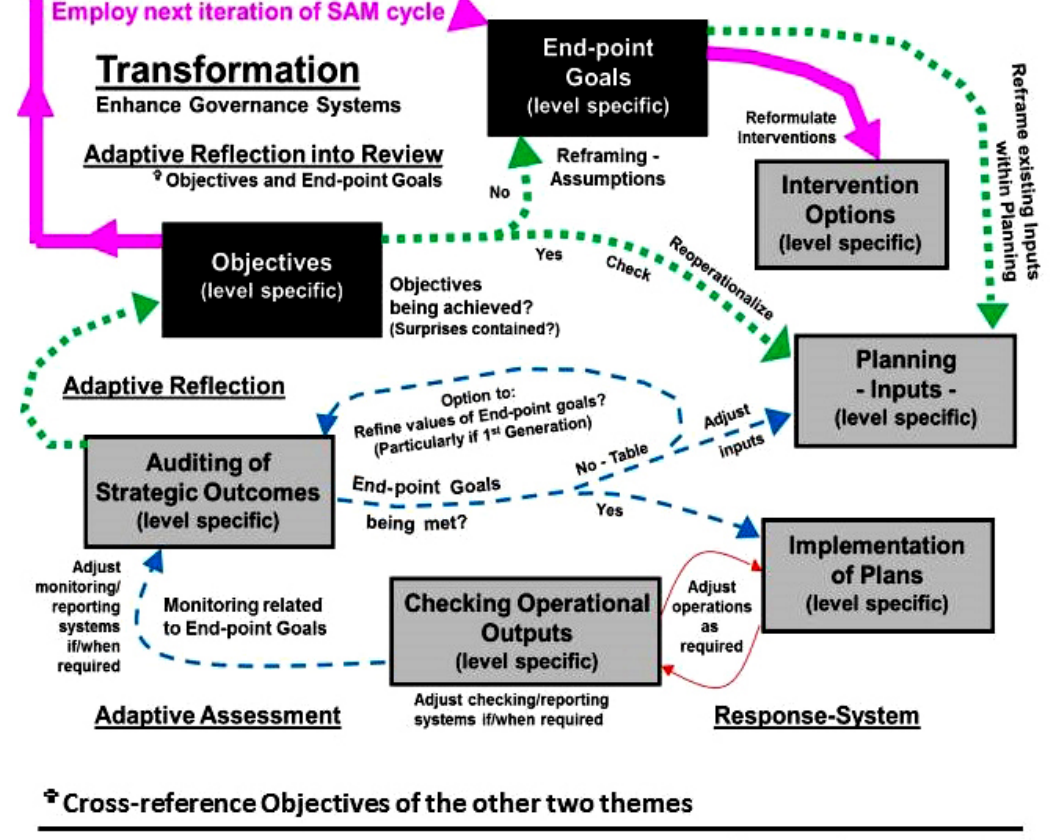
Fig. 5 . The learning process is not linear in the Strategic adaptive management (SAM) Reflexive Learning Framework (SRLF). SRLF uses a nested set of generic adaptive feedbacks within each SAM cycle, and this is applied at SRLF Level-1, Level-2, and Level-3 as described in Table 2. These feedbacks occur simultaneously but over increasing time-scales for change, by providing potential for both Adaptive and Transformational learning (vis-à-vis Pahl-Wostl et al. 2013). This is given effect by facilitation of three-mode learning, in relation to meeting Objectives and associated End-point Goals, which allows for activation, completion, and regeneration of the SAM cycle. Specifically, by allowing for more immediate responses to check operational outputs (red, solid arrows); adaptive assessment, to audit strategic outcomes against End-point Goals (blue, hashed arrows); adaptive reflection, to test achievement of the Objectives (considering any surprises; green, dotted arrows); and review, a holistic revision of the Objectives and associated End-point Goals, with transformation of governance arrangements to improve application of the SAM cycle (pink, thick solid arrows). It is important that when reviewing Objectives and associated End-point-Goals for one particular theme, there is cross-reference to the other two themes where pertinent. For comparison, hypothetical time-scales for learning loop types within the SAM cycle, at different governance levels in SRLF, are: Level-1 > 3-5 years (single-loop, lower), 5-8 years (single-loop, upper), 8-10 years (double-loop), and 10-15 years (triple-loop); Level-2 > 1-3 years (single-loop, lower), 3-6 years (single-loop, upper), 6-8 years (double-loop), and 8-10 years (triple-loop); Level-3 > daily/weekly (single-loop, lower), 1-3 years (single-loop, upper), 3-5 years (double-loop), and 5-6 years